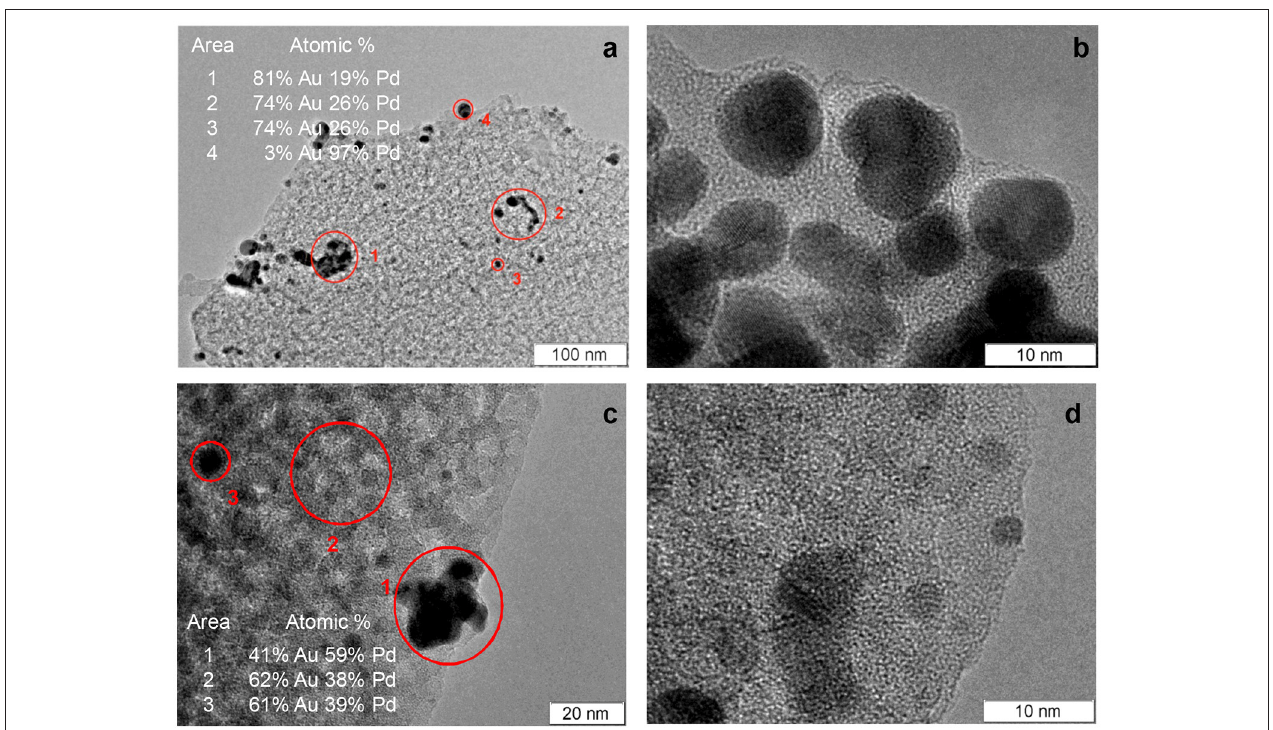
FIGURE 4 | TEM images of PdAu 2 /PSi (a , b) and Pd-Au/PSi (c , d) catalysts and EDX analysis data (a , c)